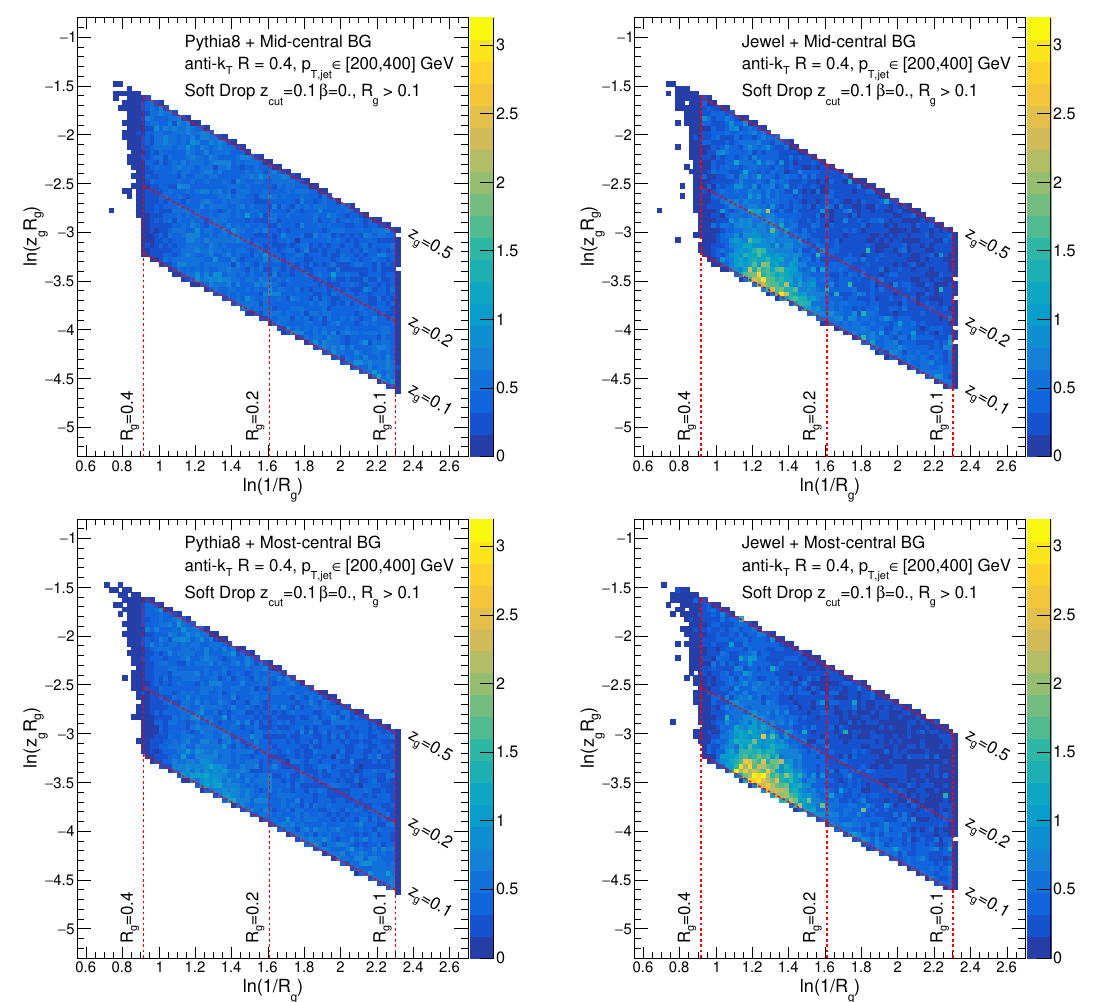
Figure 4 . Primary Lund plane density for the mid-central (upper) and the most-central (lower) mixing